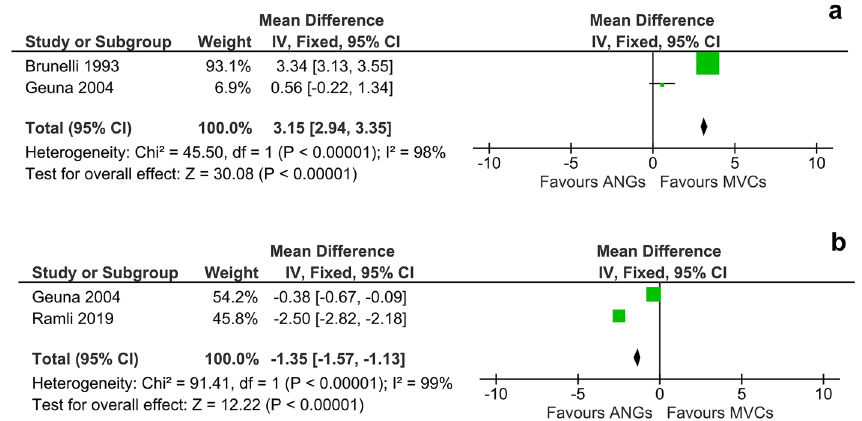
Figure 4. Meta-analysis of the number of axons in the distal nerve stump ( a ) and the size of the myelinated fibers ( b ) within the grafted ANG or MVC at twelve weeks following sciatic nerve reconstruction (preclinical). Analysis of axon numbers ( a ) at WPO12 revealed a statistically significant (p < 0.01) effect of nerve reconstruction by means of MVCs compared to ANGs. There was high heterogeneity (I 2 = 98%) among the evaluated studies. Note that the scale of the Forrest-plot was adapted to 1000 axons/mm 2 as the software allows a maximum scale of 1000. Analysis of the size of myelinated fibers ( b ) at WPO12 showed a significant effect (p < 0.01) in favor of nerve repair by means of ANGs. We observed a high heterogeneity of I 2 =